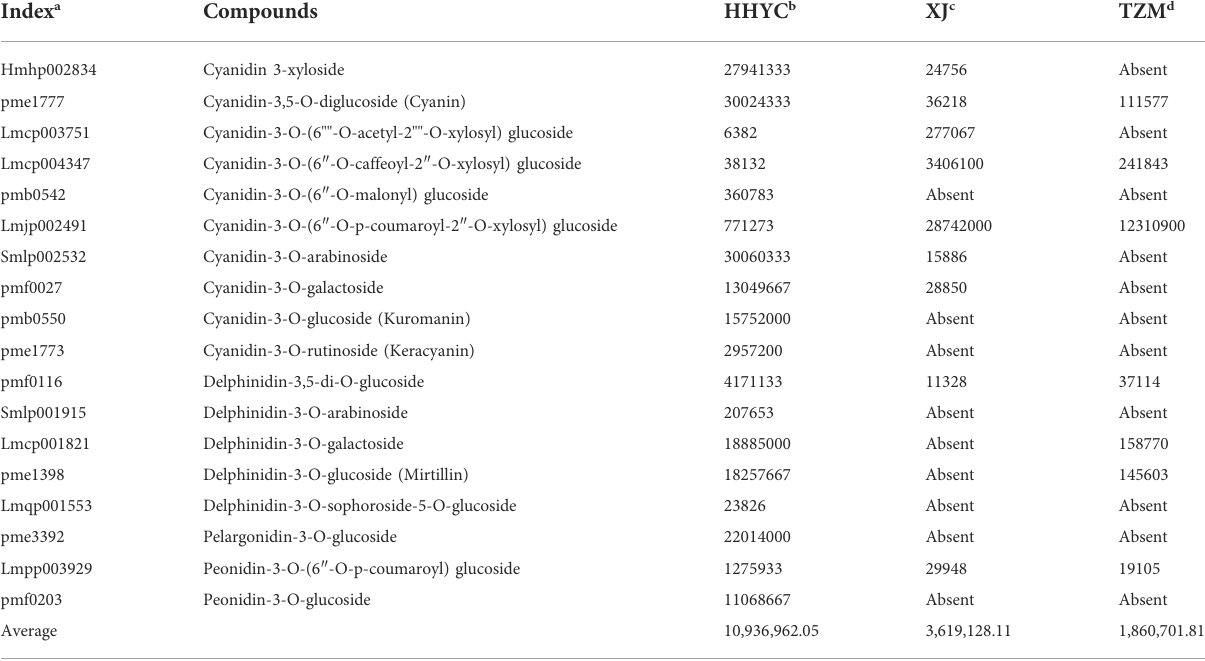
TABLE 3 Ion intensities of anthocyanin-based differentially accumulated metabolites among petals from three contrasting fl owers of C. reticulata . Index